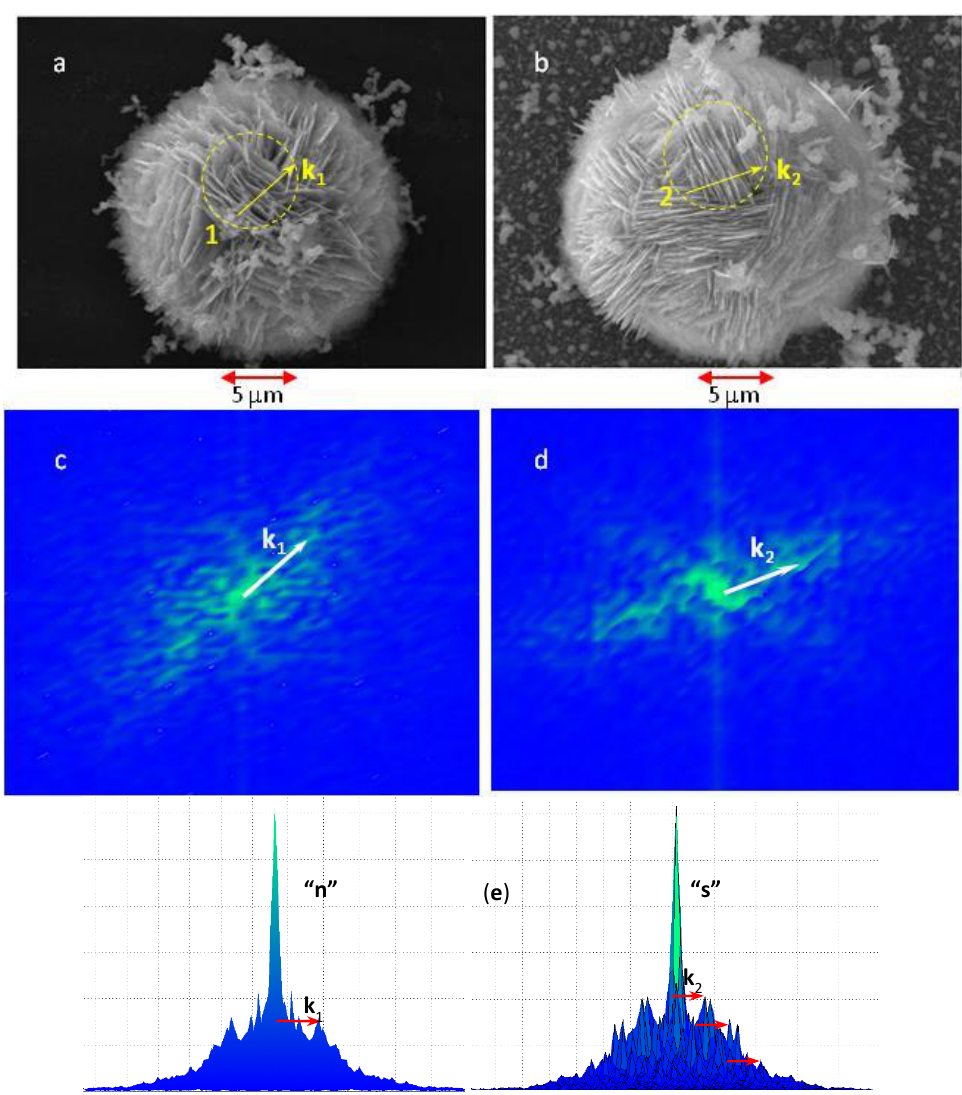
Figure 2. Scanning electron micrographs of the silver flowers on ‘n’ substrates ( a ), and ‘s’ substrates ( b ). FT amplitude patterns of areas 1 ( c ) and 2 ( d ). Vectors k 1 and k 2 are the corresponding propagation wavevectors of structures in areas 1 and 2. ( e ) A plot of the FT amplitude along Y- direction for the two areas. Overtones of the wavevector k 2 are also marked.